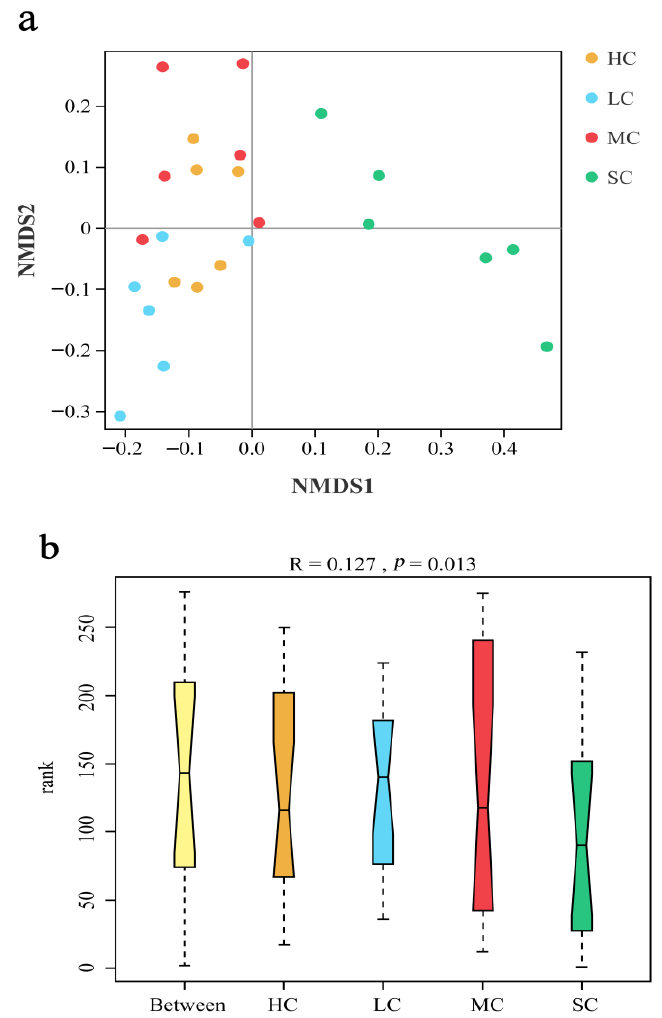
Figure 5. Non-metric multidimensional scaling (NMDS) ordination ( a ) and ANOSIM ( b ) of caecal microbiota (based on the unweighted UniFrac distance) in birds from HC, LC, MC, and SC. NMDS1 and NMDS2 on the x - and y -axes represent two principal discrepancy components among groups. Points represent samples. Samples in the same group share the same colour. HC, huge cage; LC, large cage; MC, medium cage; SC, small cage.